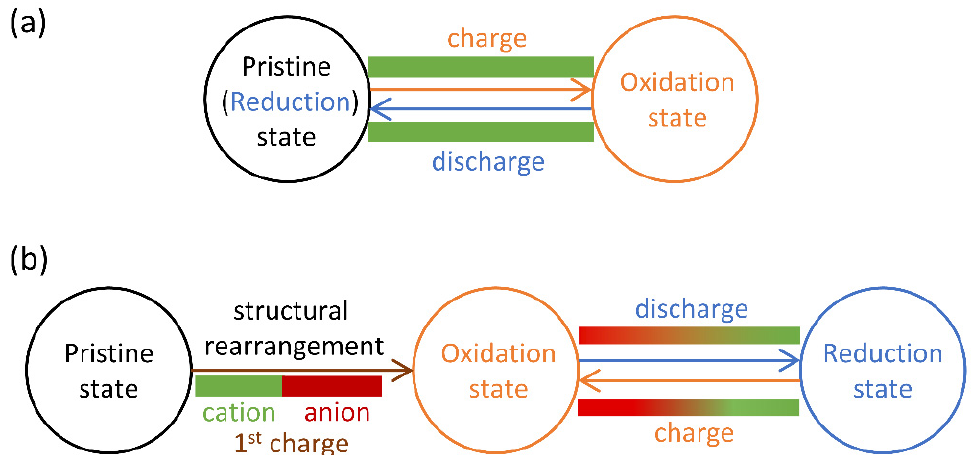
Figure 1. The schematic diagrams of redox evolution in ( a ) conventional cathodes and ( b ) Li-rich layered